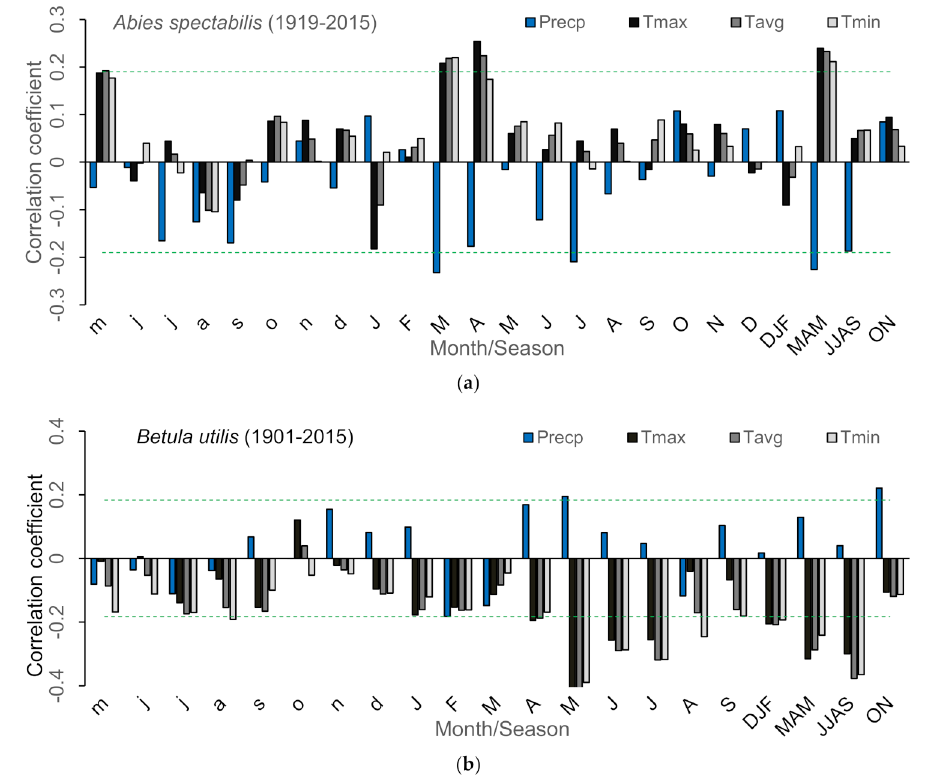
Figure A3. Radial growth-climate correlations of ( a ) Abies spectabilis (1919–2015) and ( b ) Betula utilis (1901–2015). Green dashed lines define 0.05 significance level. Lowercase letters on the x-axis are months of previous years, and uppercase letters are the current year months. DJF, MAM, JJAS and ON are winter, spring, summer and autumn seasons